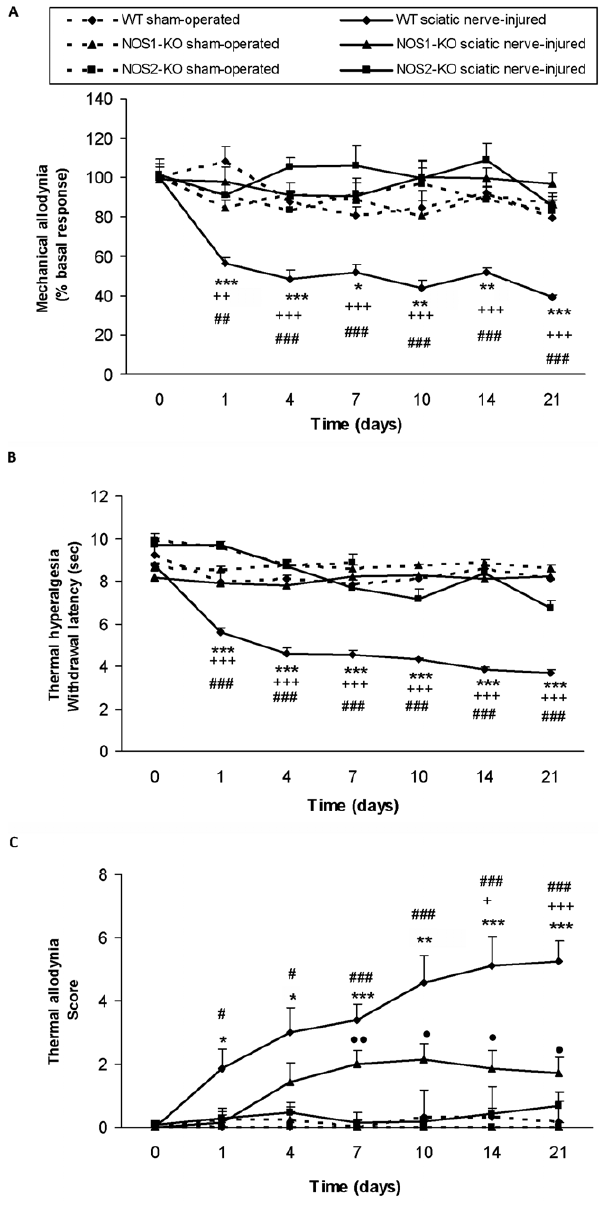
Figure 1. Effect of NOS1 and NOS2 deletion on sciatic nerve injury induced mechanical allodynia, thermal hyperalgesia and thermal allodynia in mice. Development of mechanical allodynia ( A ), thermal hyperalgesia ( B ) and thermal allodynia ( C ) in the ipsilateral paw of WT, NOS1-KO and NOS2-KO mice at 0, 1, 4, 7, 10, 14 and 21 days after sciatic nerve ligation. For each test and time tested, * indicates significant differences when compared sciatic nerve-injured WT mice vs. sham-operated WT mice (* p , 0.05, ** p , 0.01, *** p , 0.001, one-way ANOVA followed by Scheffe test), + when compared sciatic nerve- injured NOS1-KO mice vs. sciatic nerve-injured WT mice ( + p , 0.05, ++ p , 0.01, +++ p , 0.001, one-way ANOVA followed by Scheffe test) and # when compared sciatic nerve-injured NOS2-KO mice vs. sciatic nerve-injured WT mice ( # p , 0.05, ## p , 0.01, ### p , 0.001, one- way ANOVA followed by Scheffe test). In the cold plate test (C), N indicates significant differences when compared sciatic nerve-injured NOS1-KO mice vs. sham-operated NOS1-KO mice ( N p , 0.05, NN p , 0.01, one-way ANOVA followed by Scheffe test). Results are shown as mean values 6 SEM; n=10–12 animals per experimental